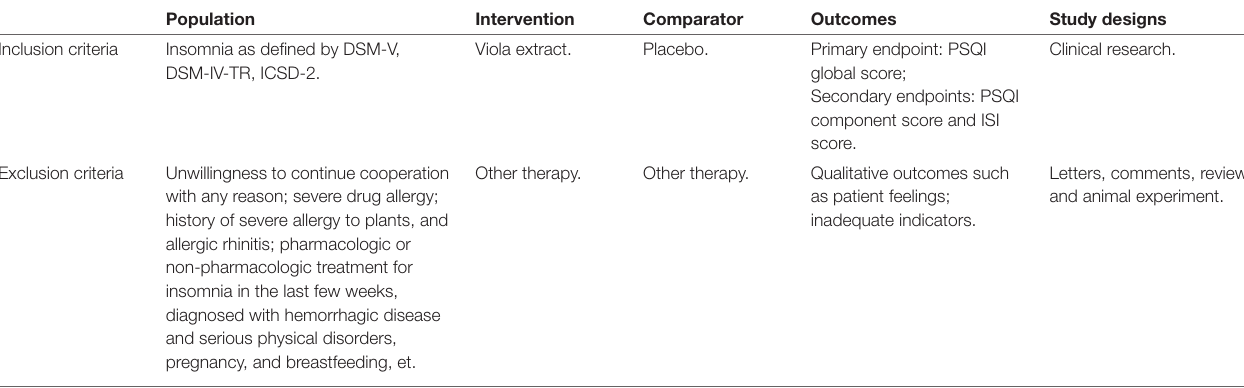
TABLE 1 | Criteria for included studies based on PICOS